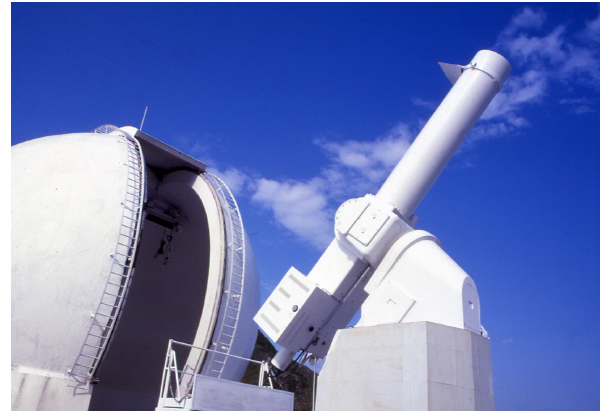
Figure 1. The Solar Magnetic Field Telescope (SMFT) at Huairou Solar Observing Station (HSOS) of BAO when it was set up in 1986. This figure is reproduced from the book by the NAOC